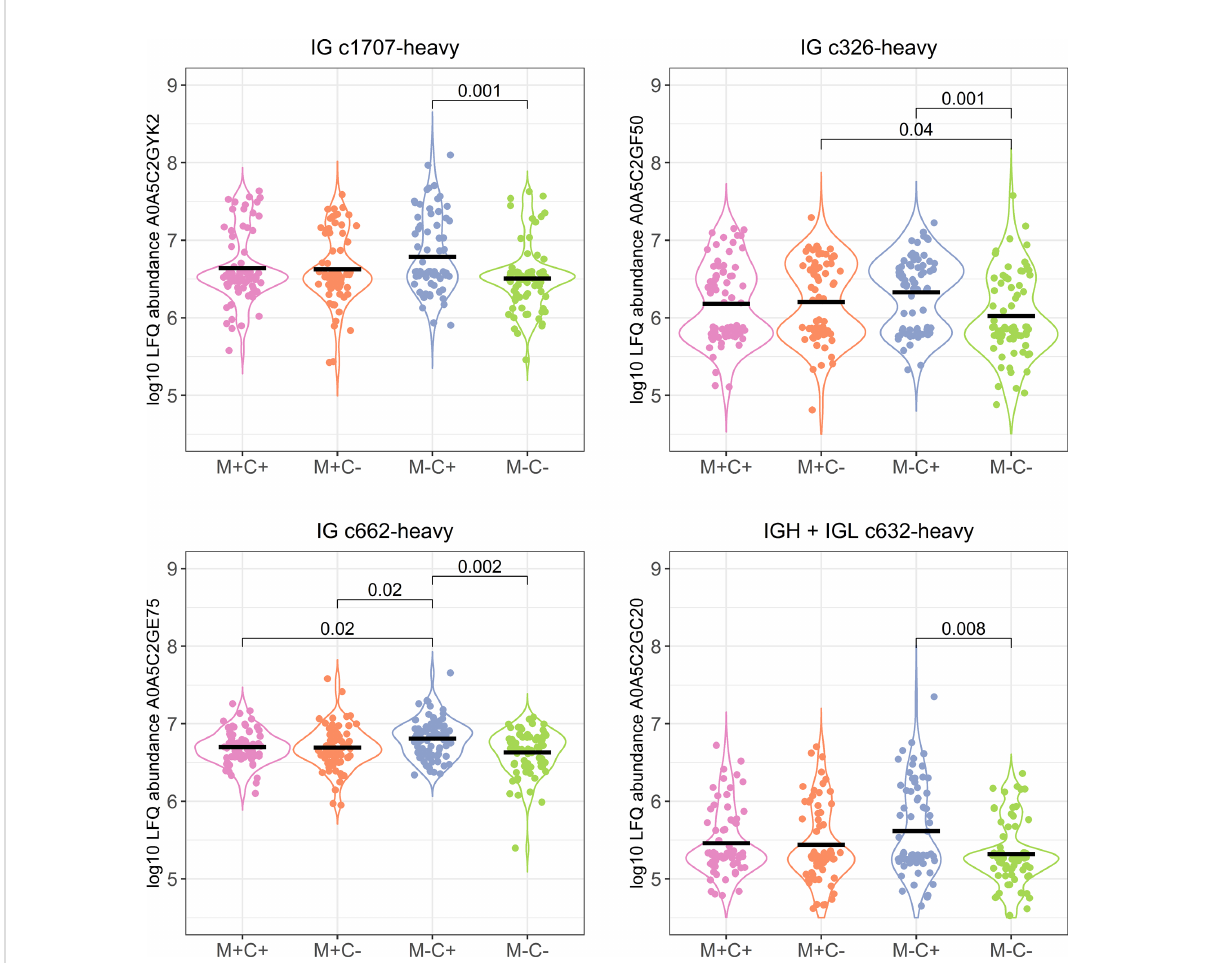
FIGURE 3 Violin plots visualizing the differences in abundance of the 4 most signi fi cantly different immunoglobulin (Ig) chains between the different allergy status groups from the CHILD Cohort Study. Differences between groups are indicated with p -values from Dunn ’ s post-hoc tests, and means of each group are shown with black, horizontal lines. In the labeling of the groups, M indicates mother, C indicates child, + indicates allergy, and - indicates no